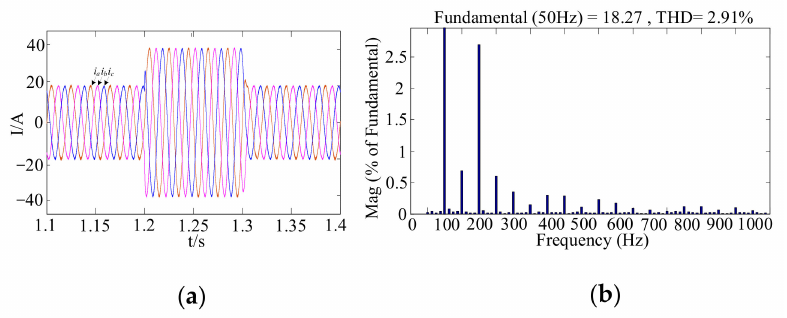
Figure 18. Compensated waveforms: ( a ) current of power grid; ( b ) THD of B-phase current.